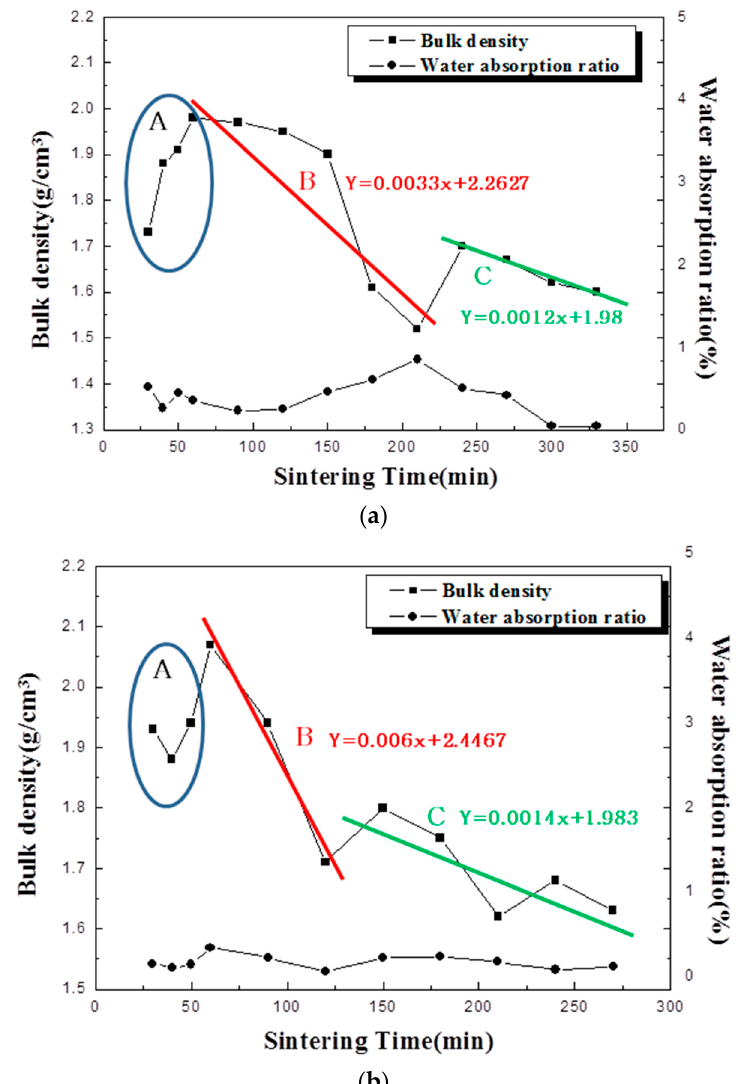
Figure 7. Bulk density and water absorption change of the aggregate according to sintering time: ( a ) input temperature 300 °C and ( b ) input temperature 600 °C .